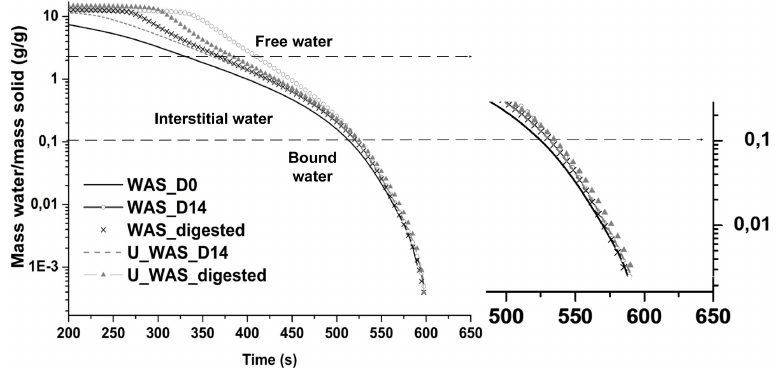
Figure 3. Drying curve of sludge samples during the digestion